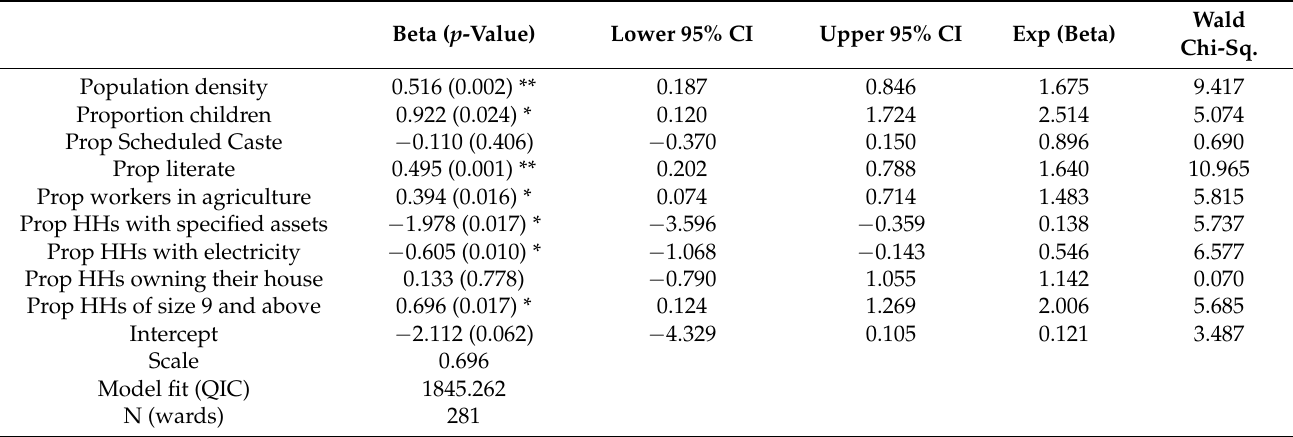
Table 2. Generalized estimating equation for predicting May UHRI using ward level socio-demographic variables.